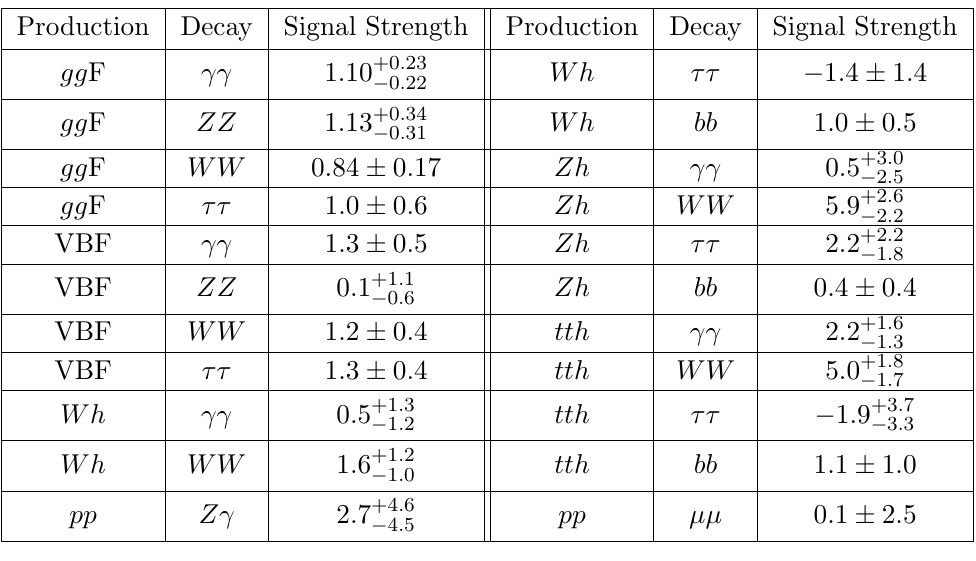
Table 2. Summary of LHC Run 1 Higgs results used in this work. All the measurements are combined CMS and ATLAS results from ref. [49], except for the Z(cid:13) result, which is an ATLAS result from ref.